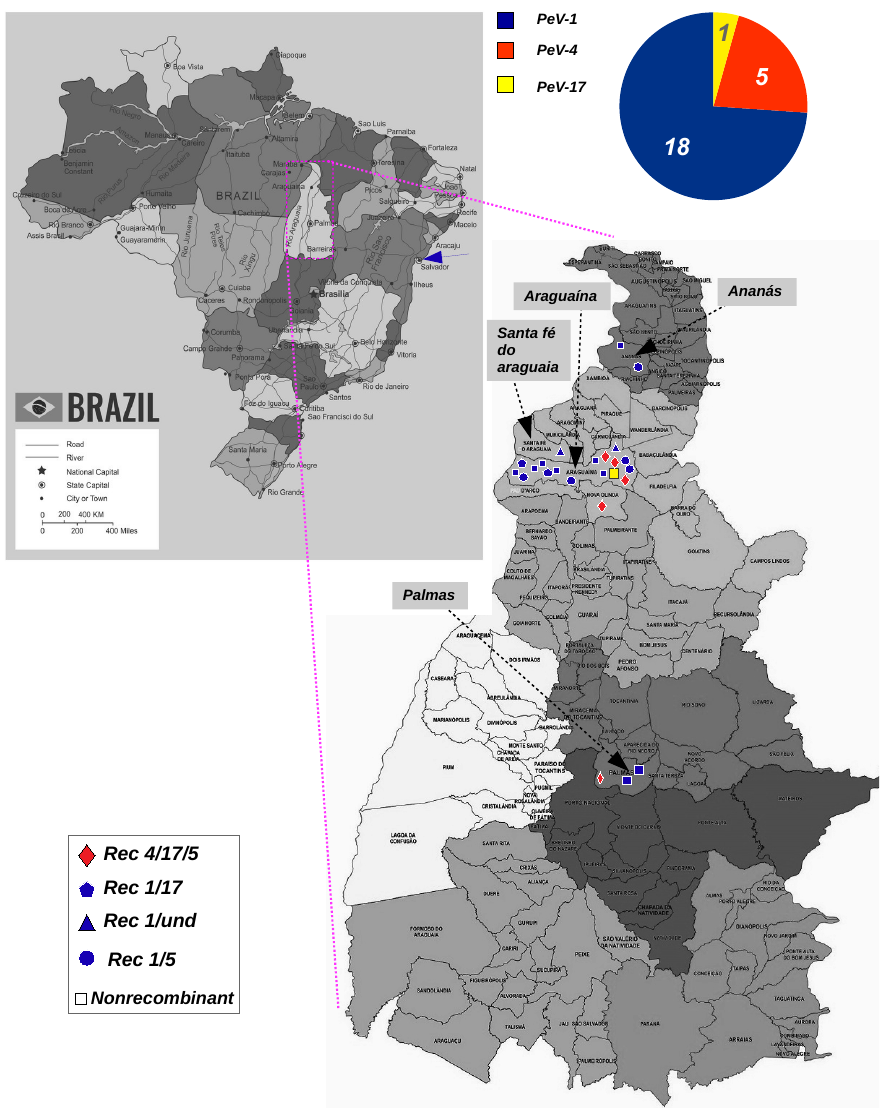
Figure 1. Location of PeV-A strains detected in Brazil. The map of Brazil is shown at the top of the figure to illustrate the region (magenta rectangle) in Tocantins state where samples were collected. A diagram shows the proportions of genotypes detected in this study (top-right). The magnified image of the region shows the cities (indicated by arrows) and the location of each PeV-A isolate. Distinct recombinant strains are represented by di ff erent shapes, as is indicated in the panel (bottom-left). Colors indicate distinct PeV-A genotypes. The blue arrows indicate the city (Salvador) where PeV-A strains were detected previously in